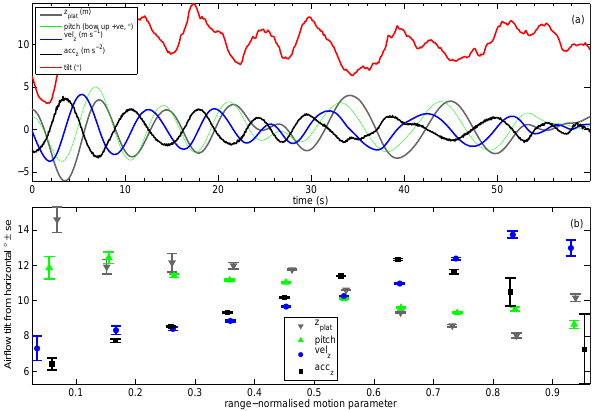
Figure 4. (a) Time series (60s) of vertical platform displacement, velocity and acceleration, platform pitch and tilt from horizontal of the streamwise airflow measured by the AutoFlux anemometer. The tilt has been smoothed with a 40-sample moving average. The measurements are sampled from a period (23 April 2013, 21:00– 21:30UTC) with near bow-on winds and mean U 10n of 15.2ms − 1 . (b) Variation of the tilt of streamwise airflow from horizontal, rela- tive to the vertical platform displacement, velocity, acceleration and platform pitch each normalised by their measured range. Tilt aver- ages were made over the 30min period that the measurements in (a) were sampled